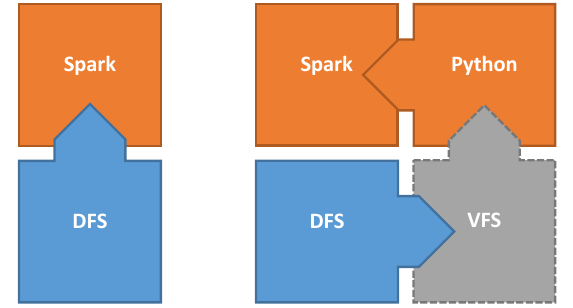
Figure 3: comparing the schematics of direct data import into Sark from a Distributed File System (DFS) versus sideloading via a Virtual local File System (VFS) and Python.